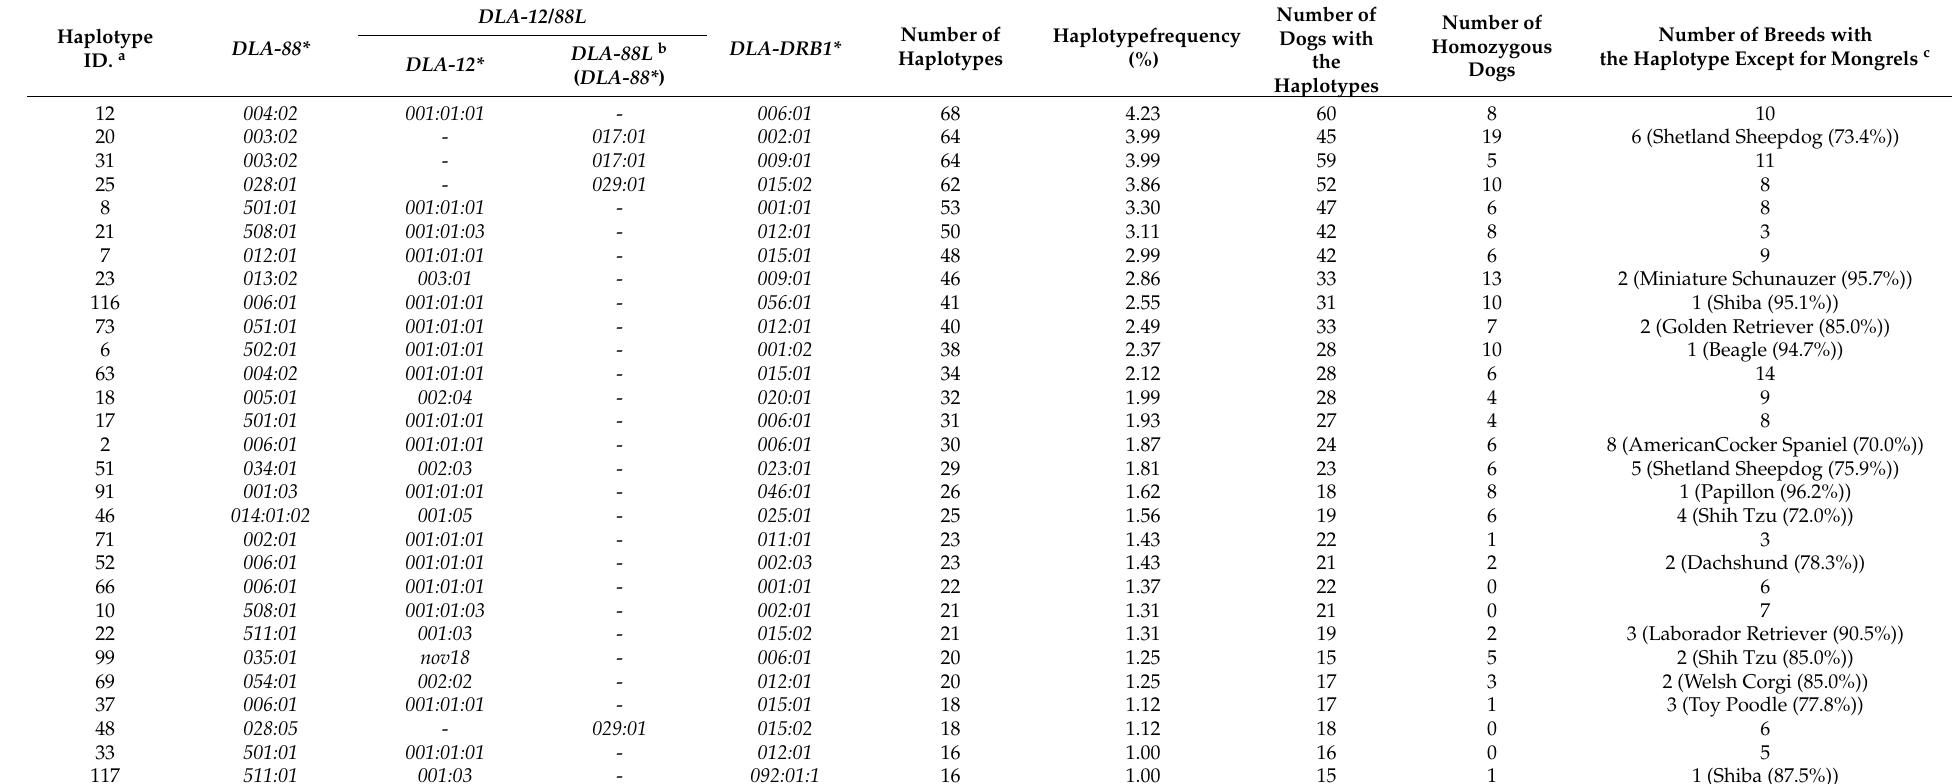
Table 4. The 29 most frequent 88-12/88L-DRB1 haplotypes found in this study.